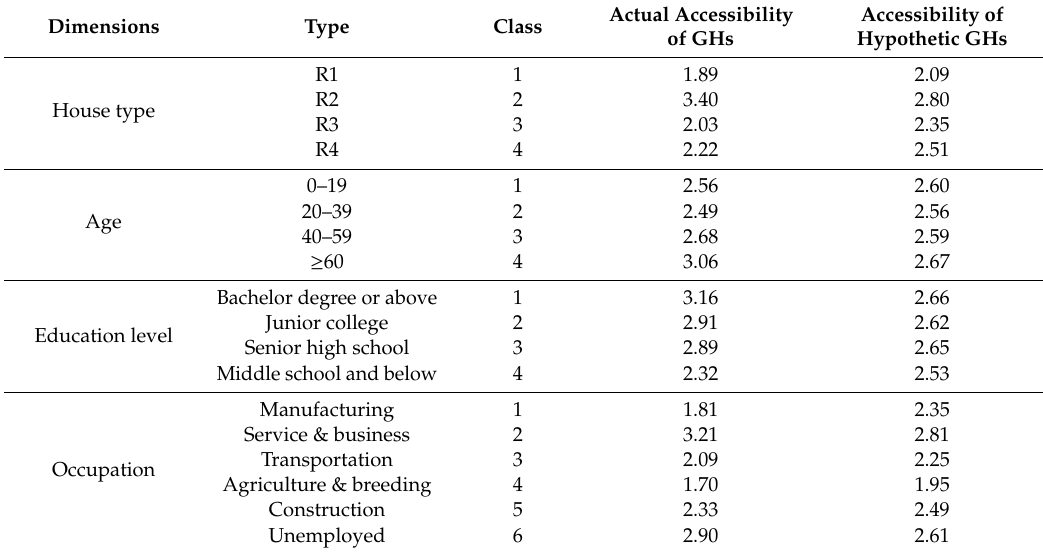
Table 3. The comparison between accessibility of GHs under actual and hypothetic